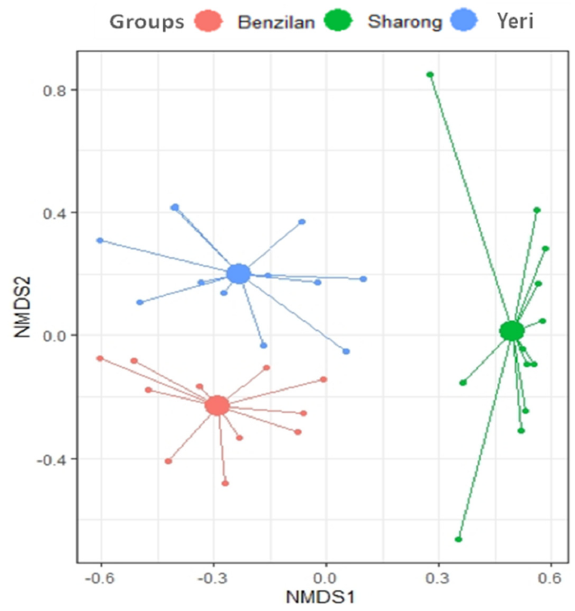
As expected, the NMDS plots showed a great distance between the species found in the three streams. The community composition of Ephemeroptera was also particularly different in the SR stream, as shown by the long distance between their centroid (Figure 3). This separation is further supported by the PERMANOVA results showing statistically significant differences in community structure across the three streams ( p = 0.001, R 2 = 0.4). The findings revealed a location effect on mayfly communities’ assemblage, but not a dispersion effect (e.g., the PERMANOVA output).